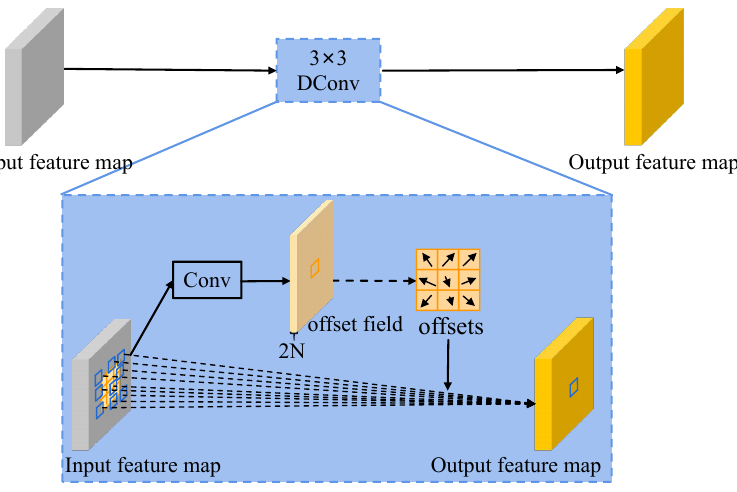
Figure 3. Flowchart of